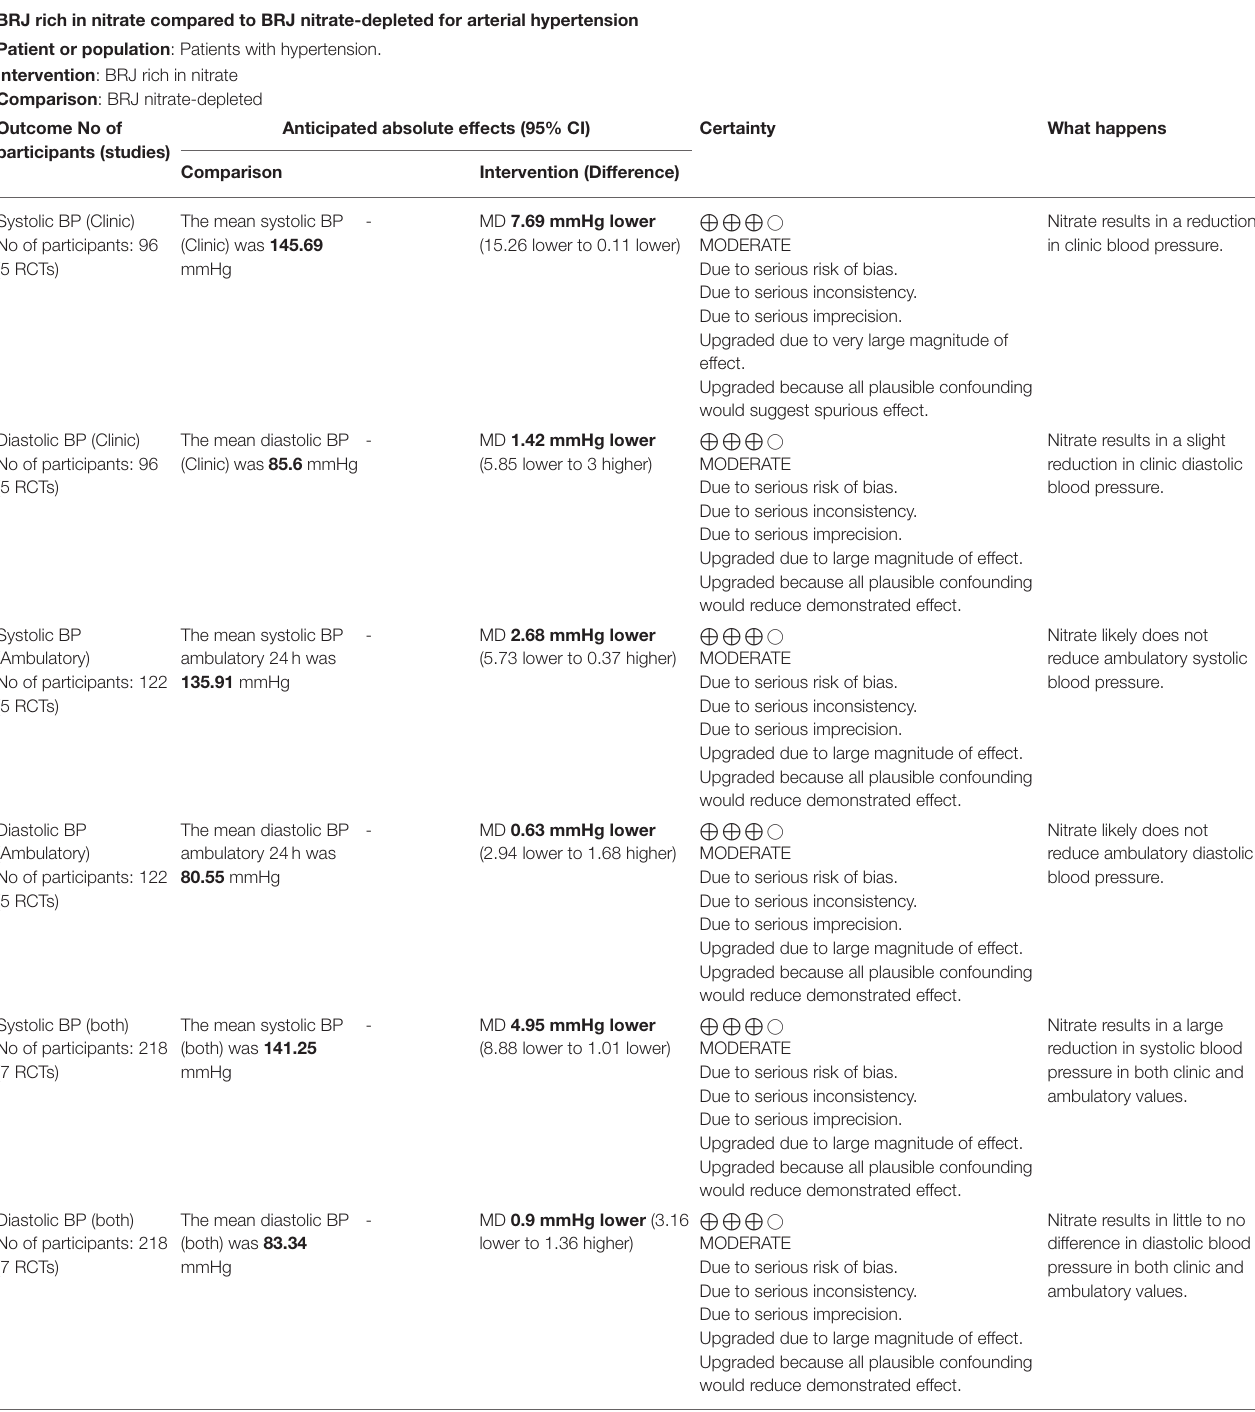
TABLE 2 | Summary of findings: GRADE. Summary of findings: BRJ rich in nitrate compared to BRJ nitrate-depleted for arterial hypertension Patient or population : Patients with